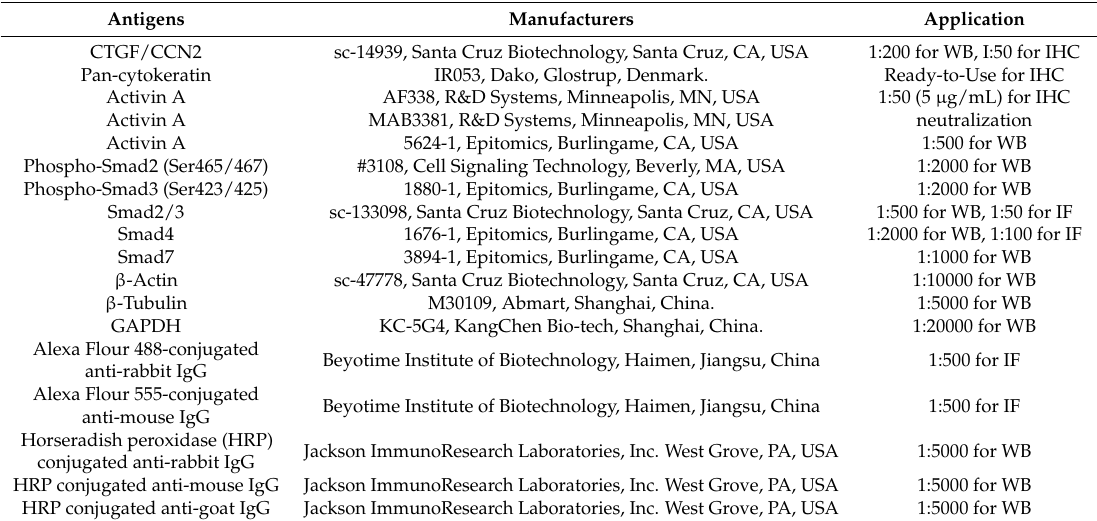
Table 2. Antibodies used in this